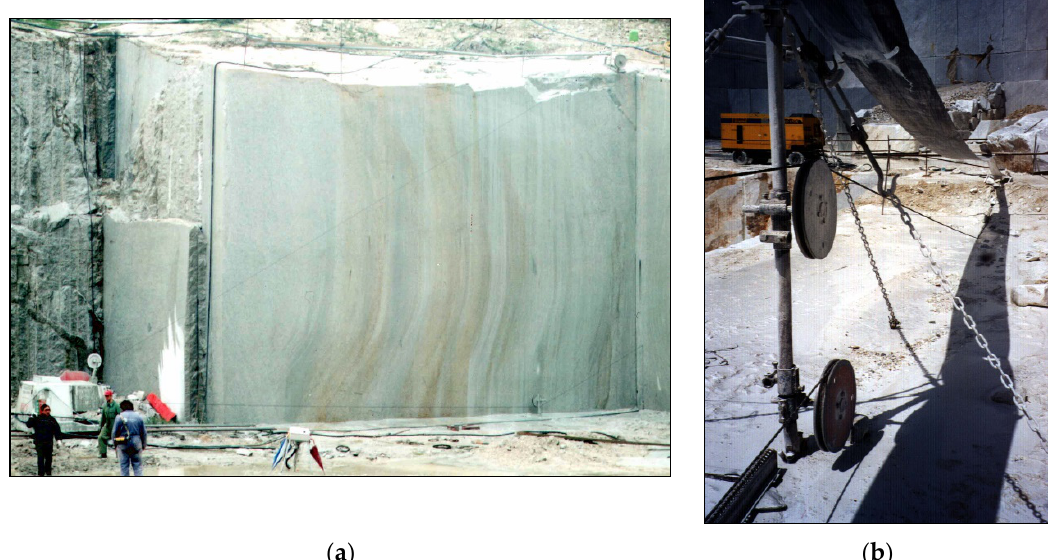
Figure 18. ( a ) Quarry face cut with diamond wire in a Sardinian granite quarry; ( b ) detail of the cut with a diamond wire saw in Carrara marble.